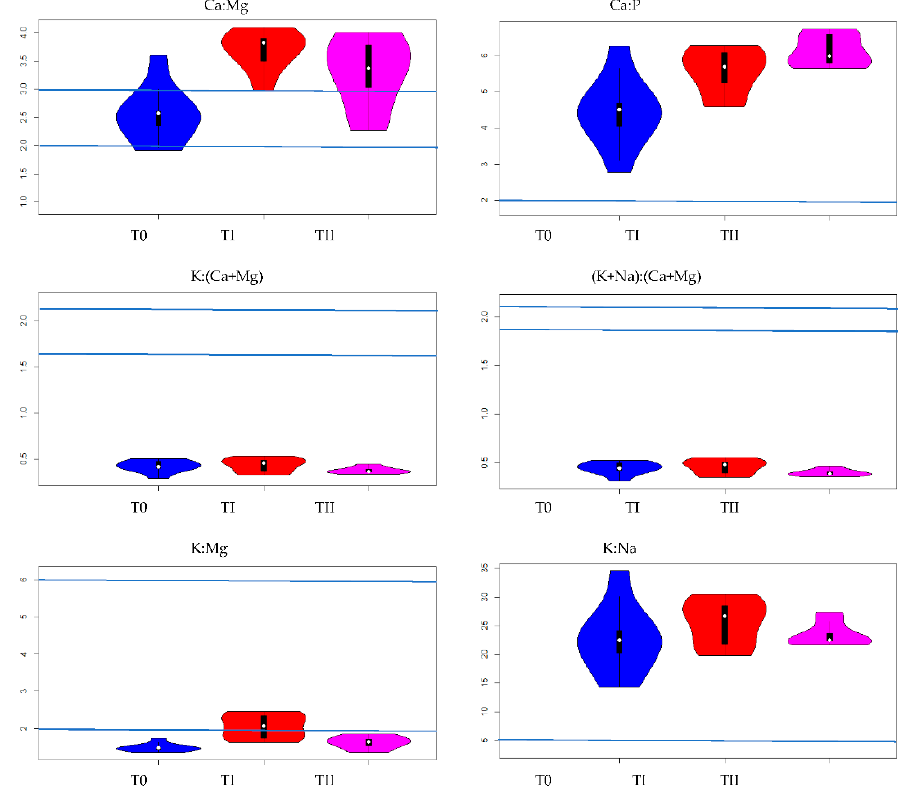
Figure 6. The effect of treating the soil with two amendments on values Ca:Mg, Ca:P, K:(Ca+Mg), (K+Na):(Ca+Mg), K:Mg and K:Na ratios in oat grown on soils: T0—control soil, TI—soil with compost addition and TII—soil with FA addition. Blue lines denote recommended optimal values of nutrient ratios [8,22].